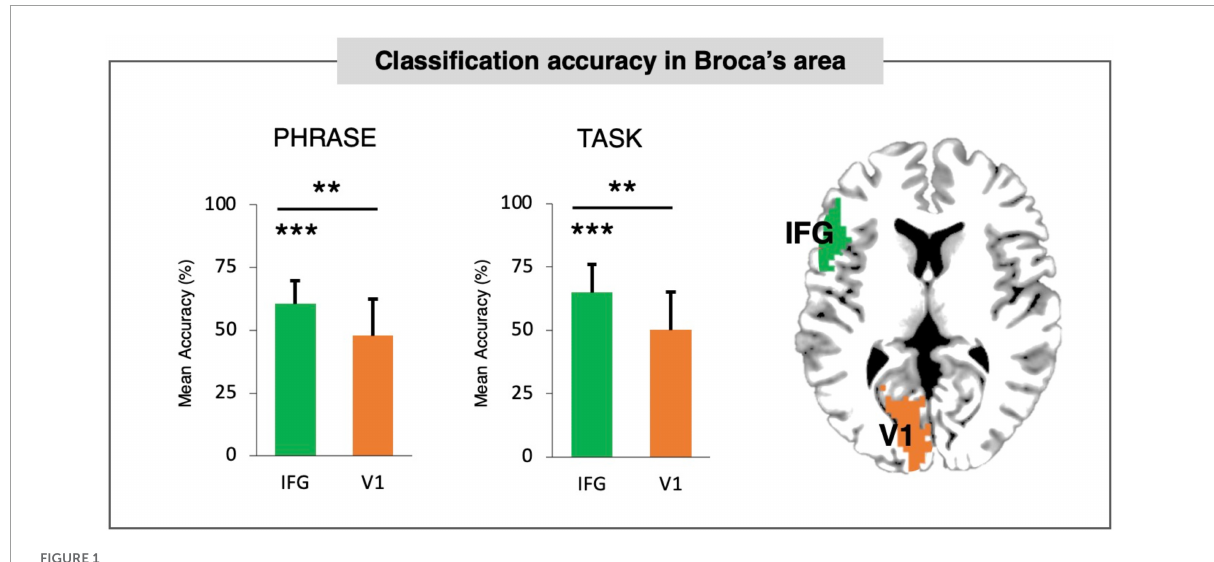
FIGURE1 Classification accuracy in Broca’s area. PHRASE classification and TASK classification accuracy for Broca’s area tested against control region (V1/BA17). Both PHRASE and TASK classifications in Broca’s area revealed significant accuracy differences compared to both control region and chance level set at 50%. Bars denote standard deviation (SD). IFG, inferior-frontal gyrus. Bars denote standard deviations. ** p < 0.005, *** p < 0.001. Figure created using the Multi-Image Analysis GUI viewer (Mango, Version 4.1; http://ric.uthscsa.edu/mango/) and MATLAB 7.14.0.739 (R2012a, Mathworks, Inc., Sherborn, MA,